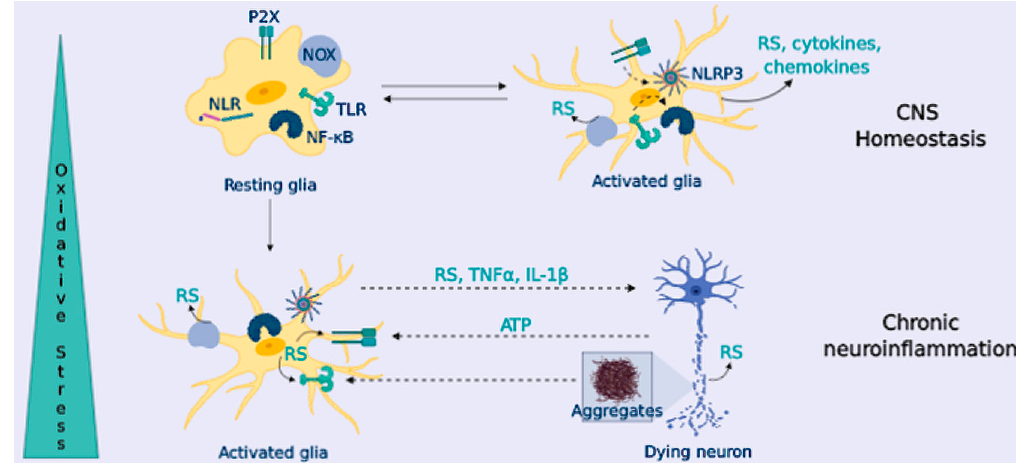
Figure 4. OS triggers chronic neuroinflammation, promoting neurodegeneration. Glial cells express TLR and NLR that sense harmful agents. Glial activation through TLR triggers the NF- κ B signaling pathway and NLR like ligand-gated ionotropic purinergic receptor (P2X) that triggers NLRP3 signaling, promoting cytokine release, and also chemokines and RS (from NOX and iNOS enzymes). In healthy CNS, glial cells resolve the inflammatory response; in NDDs, the presence of protein aggregates and factors released from dying neurons leads to a sustained glial activation that contributes to neuronal demise.